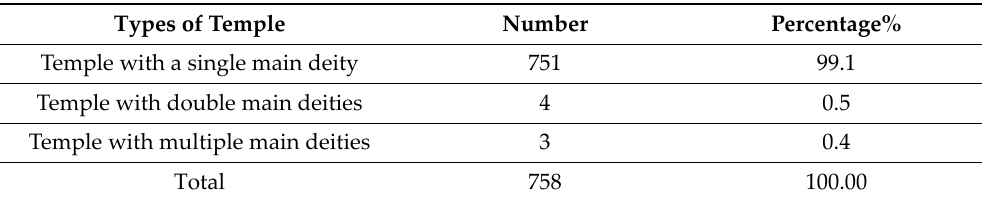
Table 9. Data of Temple With Single, Double, and Multiple Main